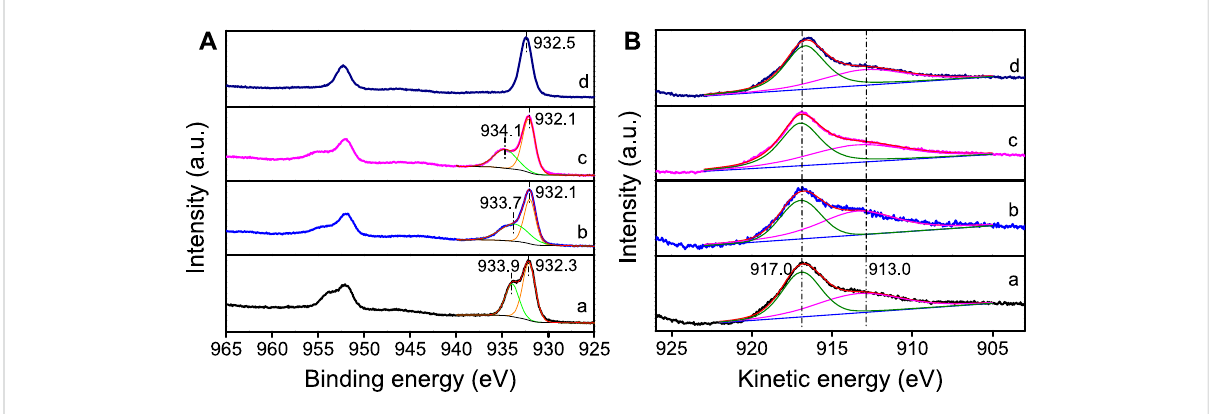
FIGURE 3 Cu 2p XPS (A) and Cu LMM XAFS (B) pro fi les of Cu/SiO 2 catalysts prepared by different method after reduction. (a) Cu/SiO 2 -EI, (b) Cu/SiO 2 -DP, (c) Cu/SiO